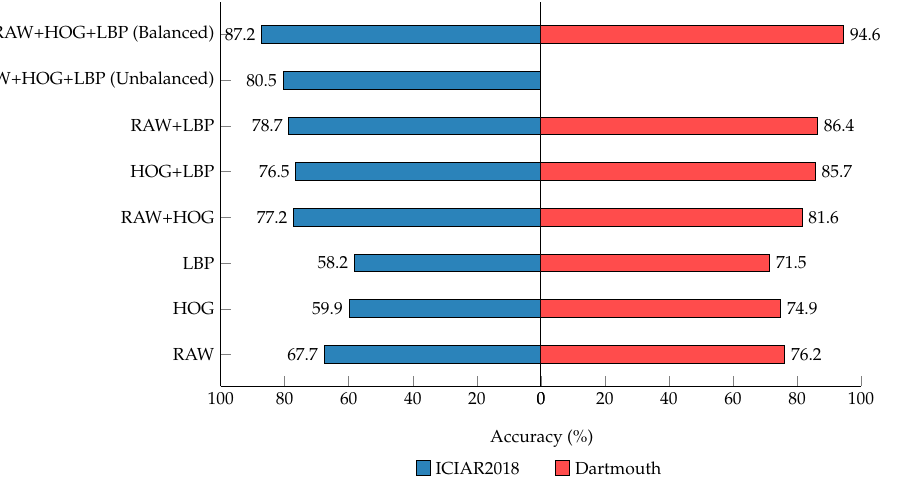
Figure 4. Accuracy for multi-class classification on the ICIAR2018 and Dartmouth datasets. Using the different combination of generated